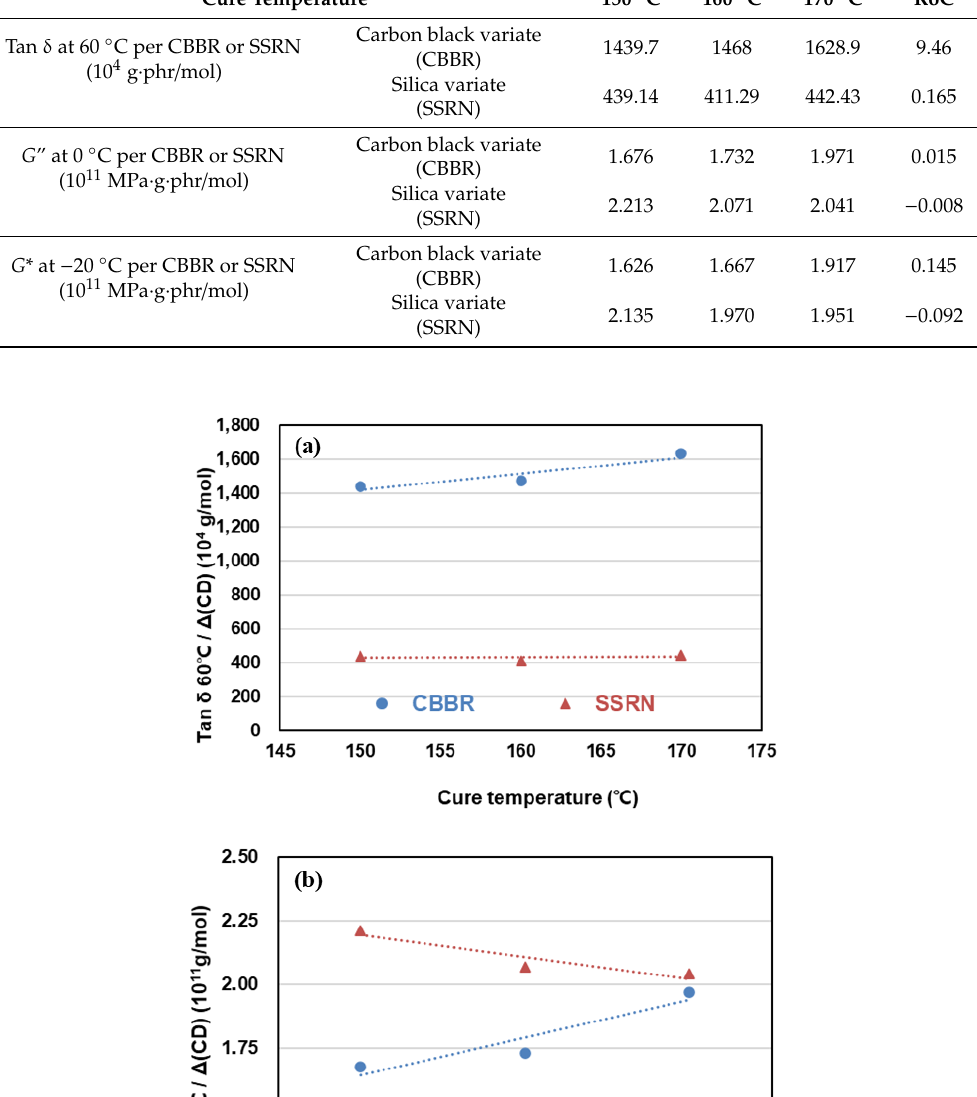
Table 7. Viscoelasticity properties per one phr of filler by di ff erent cure temperatures. Cure Temperature